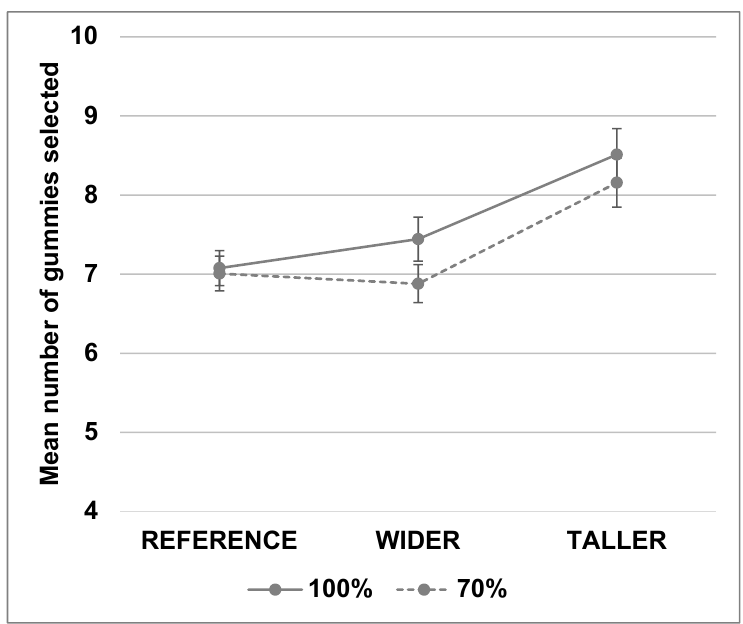
Figure 5. Mean number of gummy candies selected ± SEM for the reference, WIDER and TALLER shape and the two sizes: 100%, 70% (reduced size).